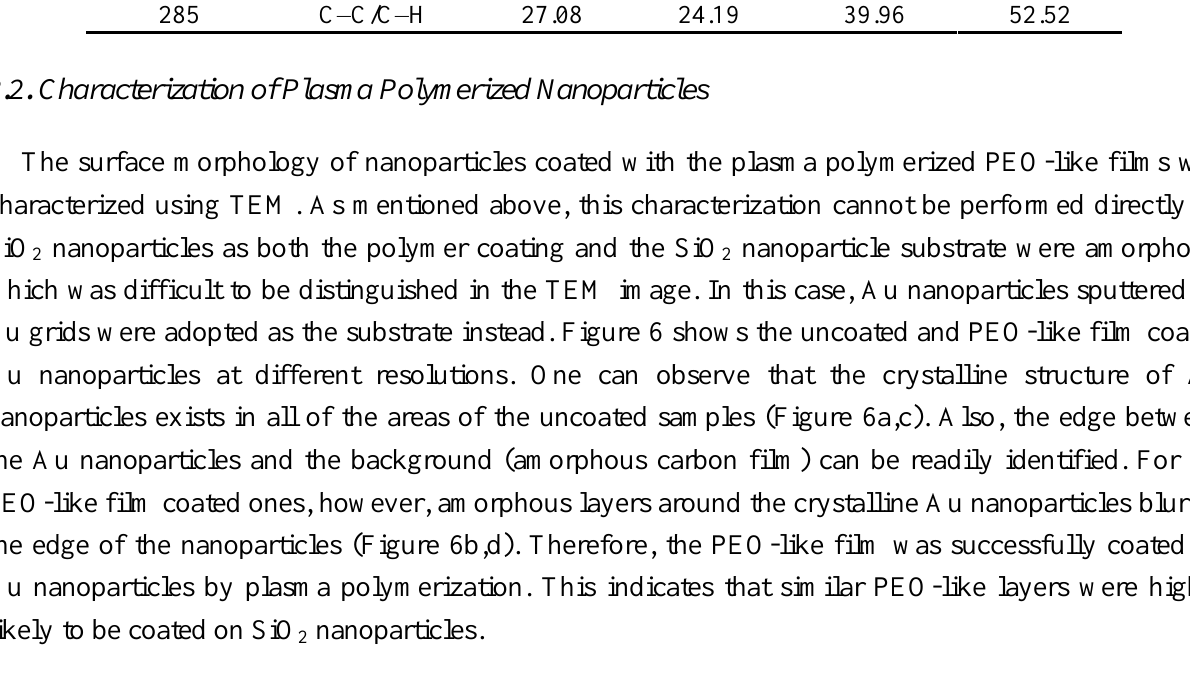
Figure 6. TEM images of plasma polymerized Au nanoparticles. ( a ) and ( c ) are uncoated Au nanoparticles with clear crystalline edges in different resolutions; ( b ) and ( d ) are PEO-like polymer coated Au nanoparticles with amorphous edges in different